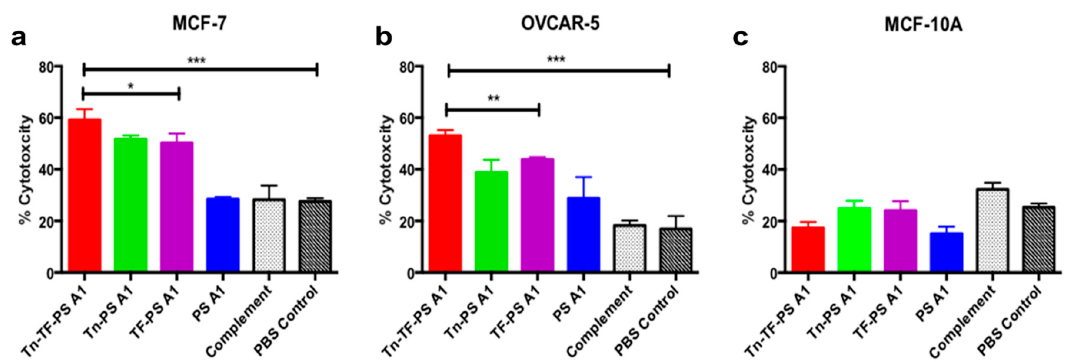
Figure 3. Antibody mediated complement dependent cytotoxicity (CDC) with antiserum obtained from mice immunized with 1 , 4a , 4b , or 4c in combination with rabbit complement. ( a ) MCF-7 cell line. ( b ) OVCAR-5 cell line. ( c ) MCF-10A cell line. Experiments were performed in triplicate. Error bars are shown as mean ± standard error of mean. Where * p < 0.05, ** p < 0.005, *** p < 0.0005 were obtained by two tailed Student’s t -test.